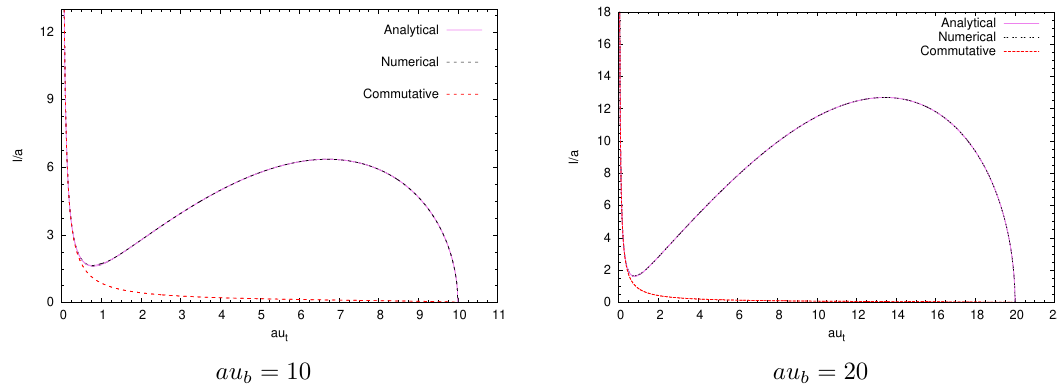
Figure 1 . Variation of l with respect to au t for two different values of the cutoff ( au b = 10 , 20 ). The a solid curve represents the analytical results given in eqs. (3.11), (3.12) and the dotted curve shows the numerical result. The red dotted curve shows the commutative result. For the analytical curves corresponding to the noncommutative case, the plots have been made using eqs. (3.11), (3.12). The value of both the functions matches at au t = 1 and is equal to 1 . 7255 (for au b = 10 ) and 1 . 733 (for au b = 20